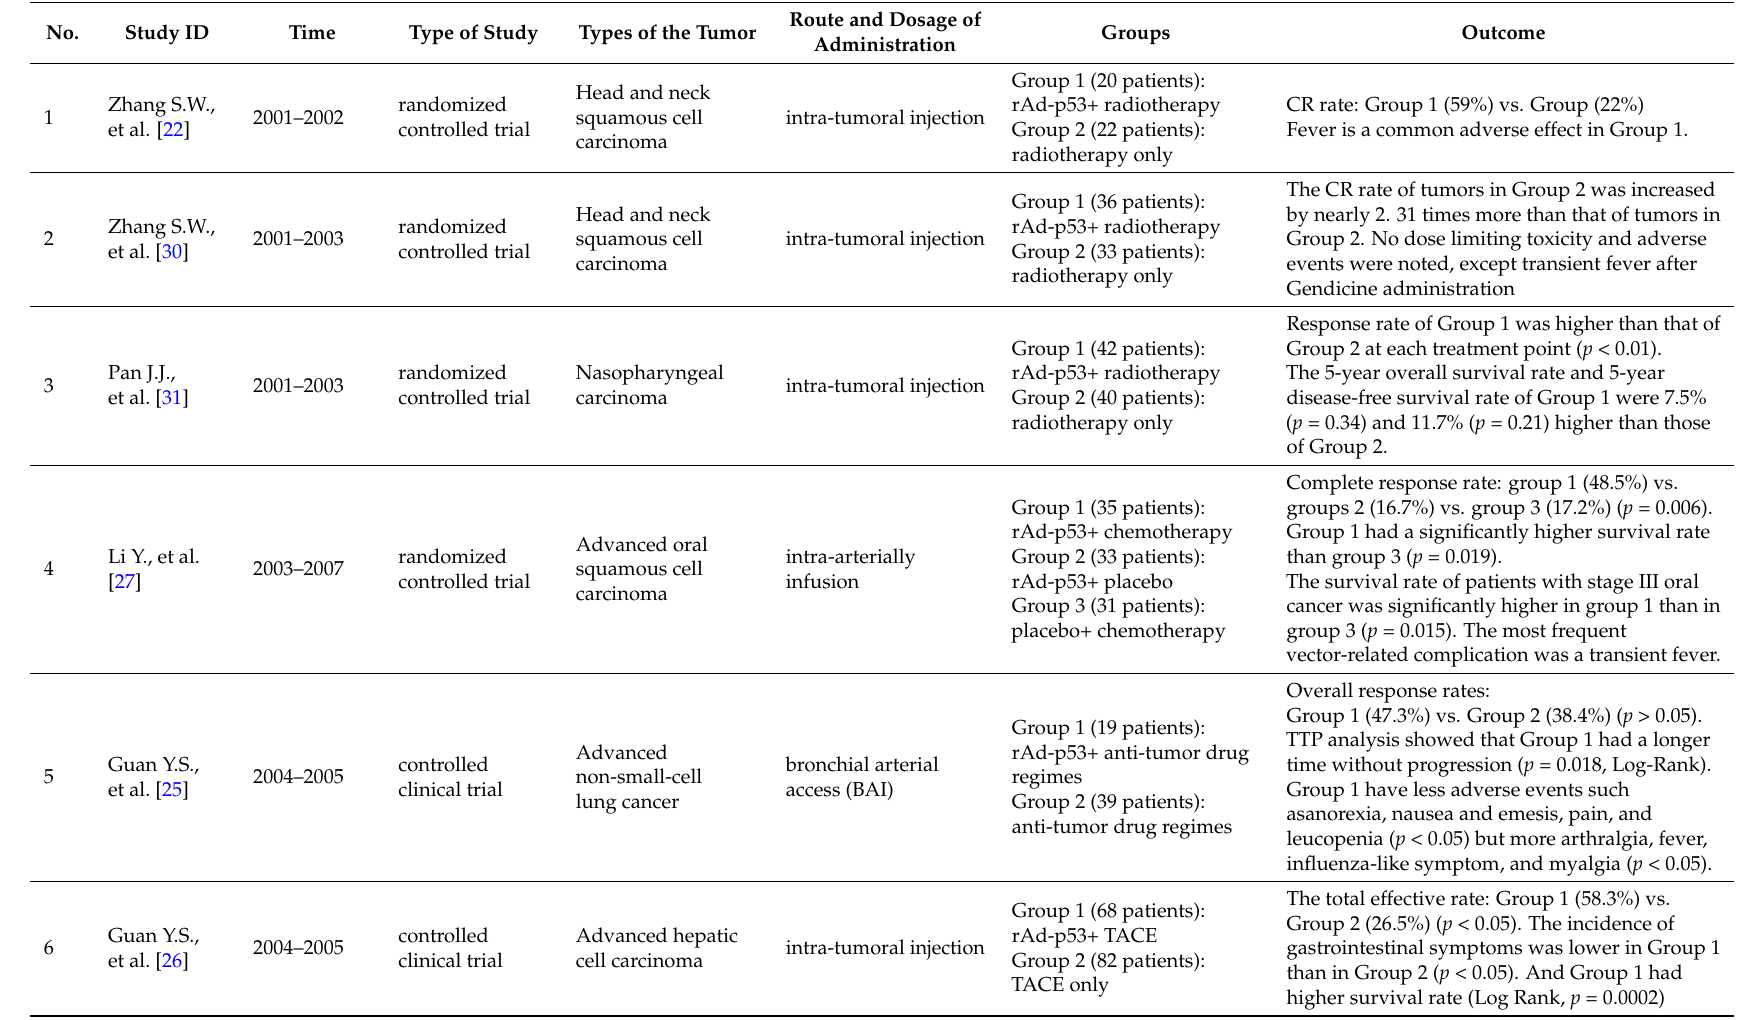
Table 1. Overview of the clinical trial of rAd-p53 in